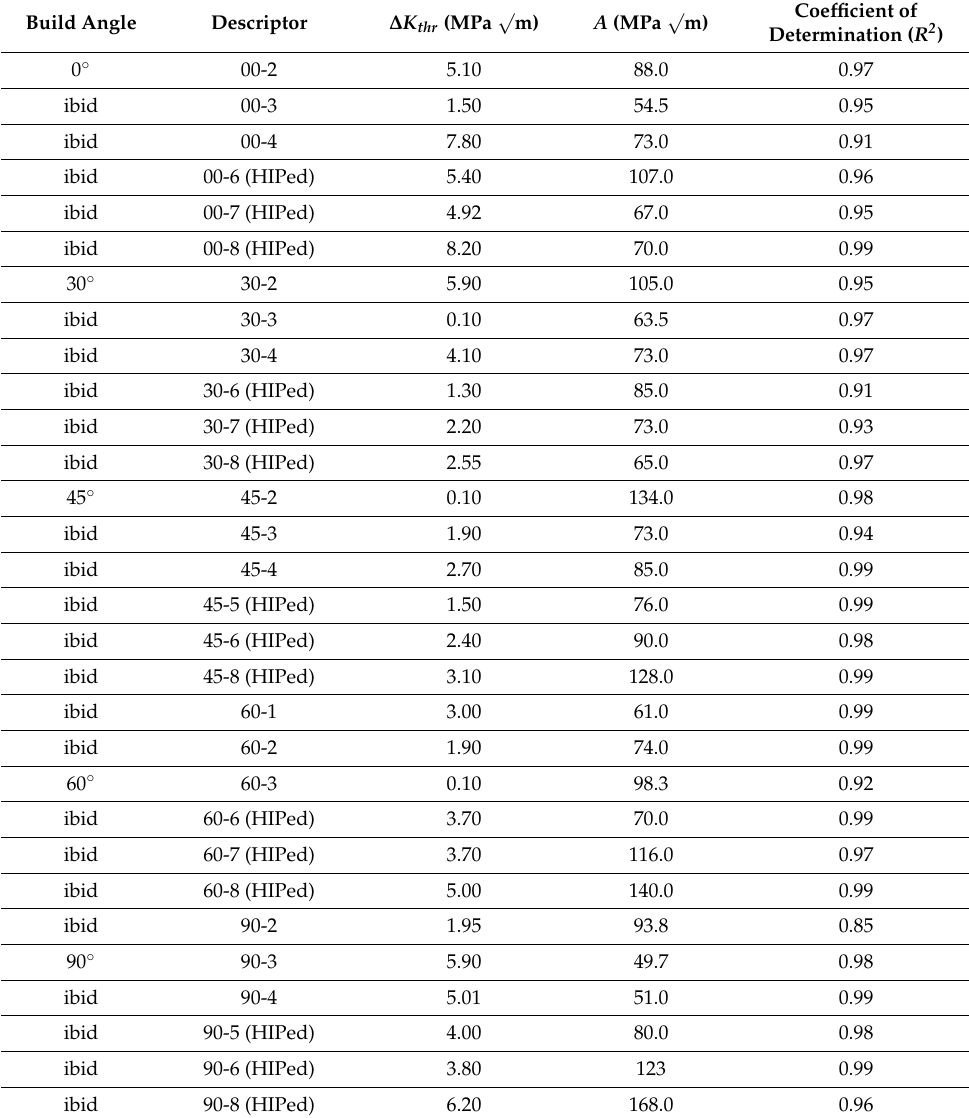
Table 2. Values used in Figure